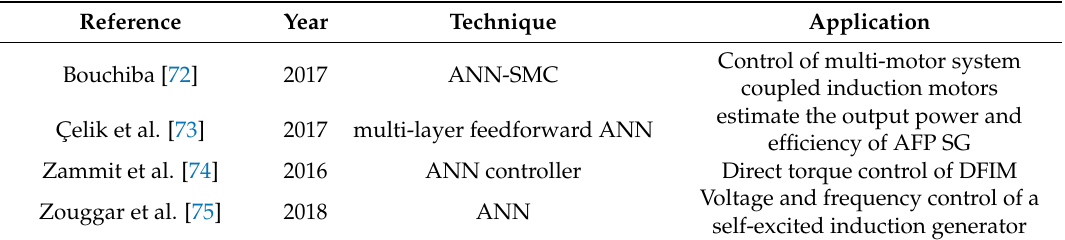
Table 4. Artificial neural networks.